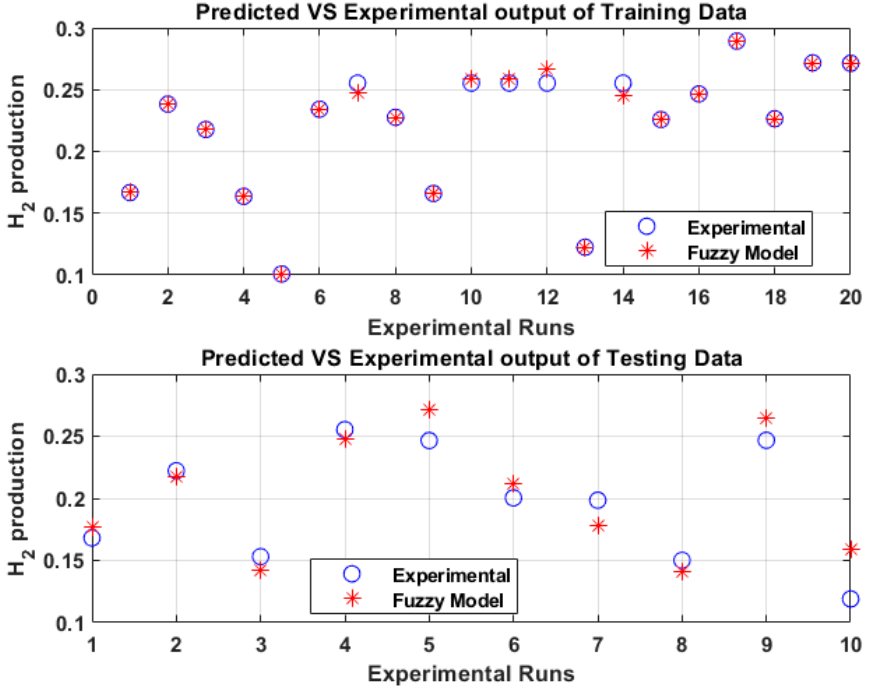
Figure 1. ANFIS model predictions versus the experimental data for training and testing data.